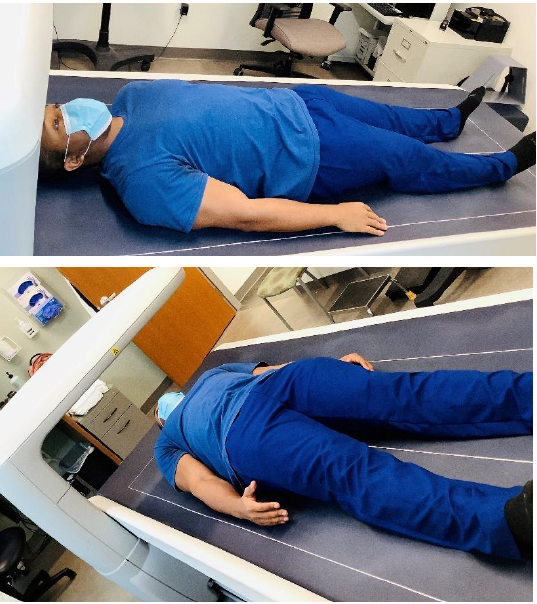
Figure 5. Dual-energy X-ray absorptiometry; photo courtesy of Clifton J. Holmes, PhD, in conjunction with the Clinical Translational Research Unit at the Washington University School of Medicine in St. Louis.